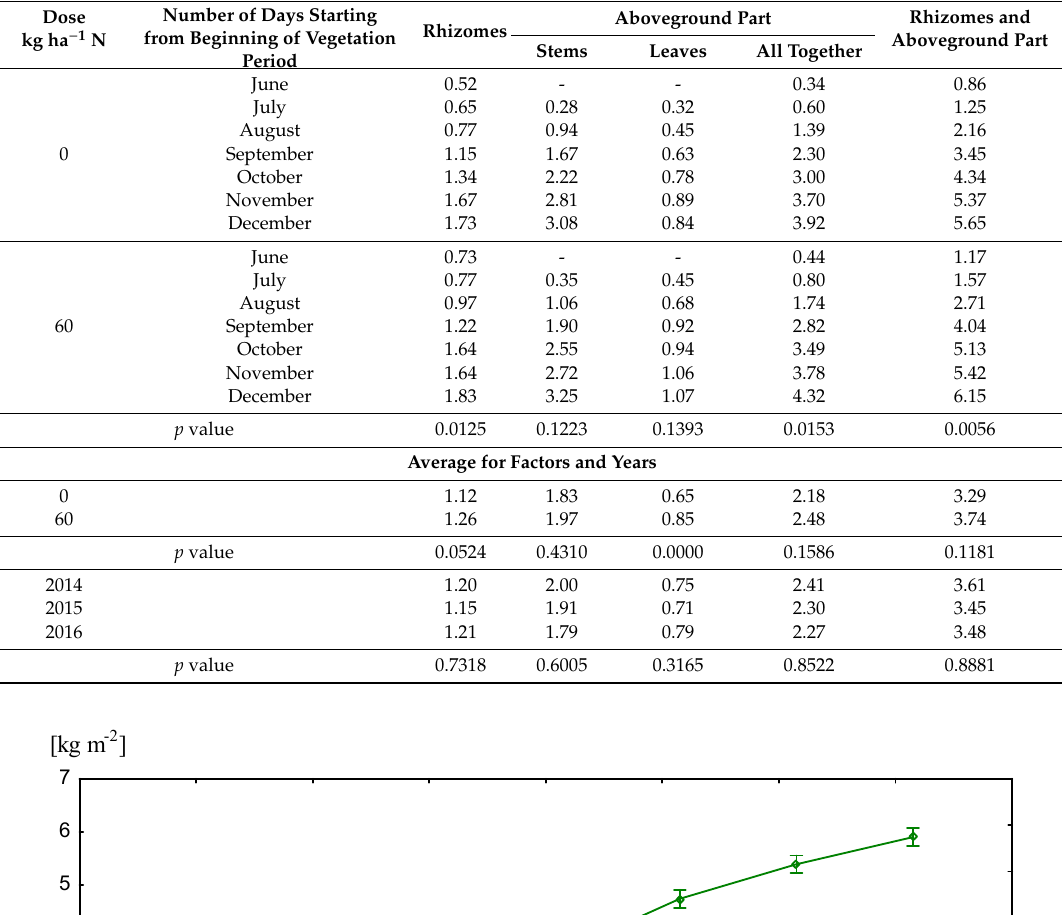
Table 6. The yield of the dry mass of Miscanthus × giganteus (kg m − 2 ) (average for years 2014–2016).